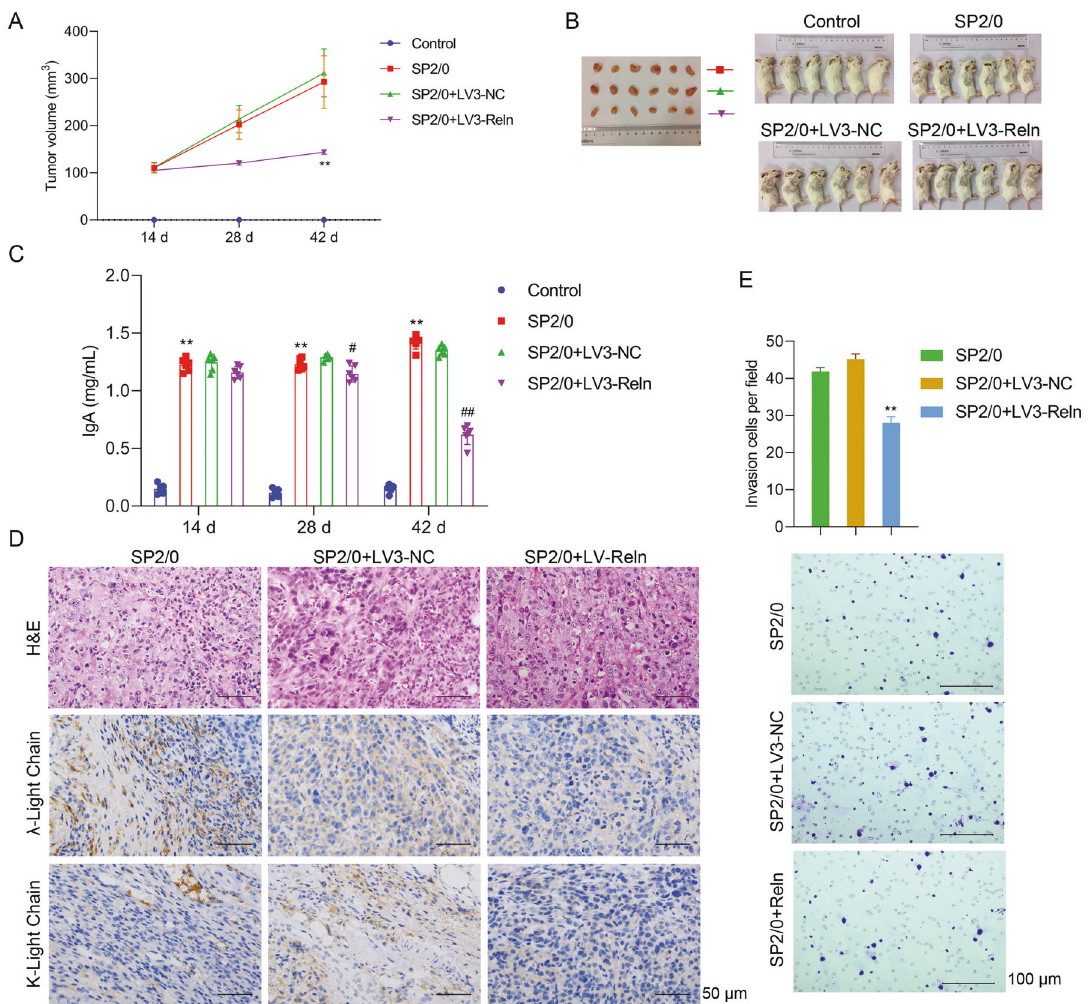
Fig. 2 Inhibition of Reelin suppressed tumor growth and invasiveness in vivo. Eight-week-old female BALB/c mice injected with LV3-Reln- or LV3-NC-transfected SP2/0 cells to knockdown Reelin expression or served as negative control ( n = 6 per group). A Tumor volume for every animal in all groups were detected at 14, 28, and 42 days. ** p < 0.01 vs. SP2/0 group. B Images of tumor tissue collected from corresponding animal groups after MM model was successfully established. C Serum IgA levels at 14, 28, and 42 days for each group were detected by